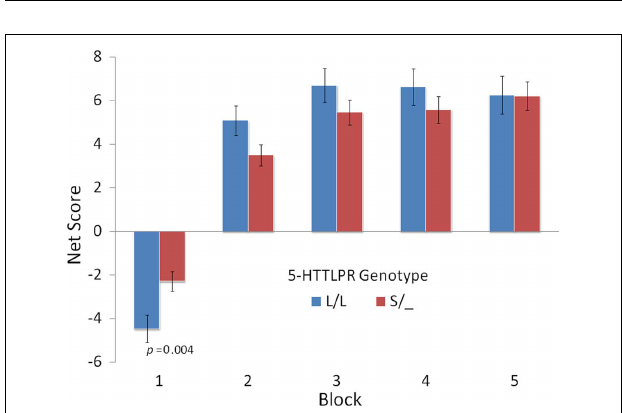
FIGURE 1 | Probability of choosing a “good” card (i.e., from decks C (cid:2) and D (cid:2) ) across 100 trials.